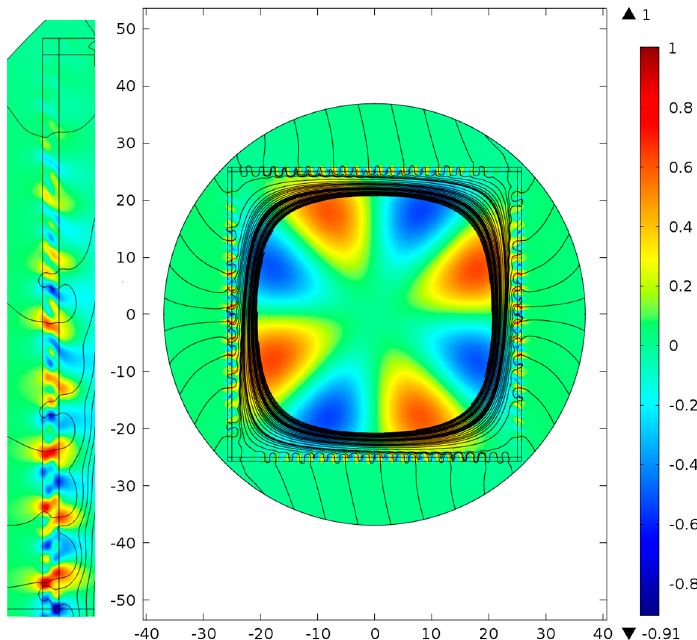
Figure 4. Distribution of the transverse Poynting vector component projection on the radius vector direction in the silica glass square waveguide microstructure cross section. The streamlines for the transverse component of Poynting vector (black lines).